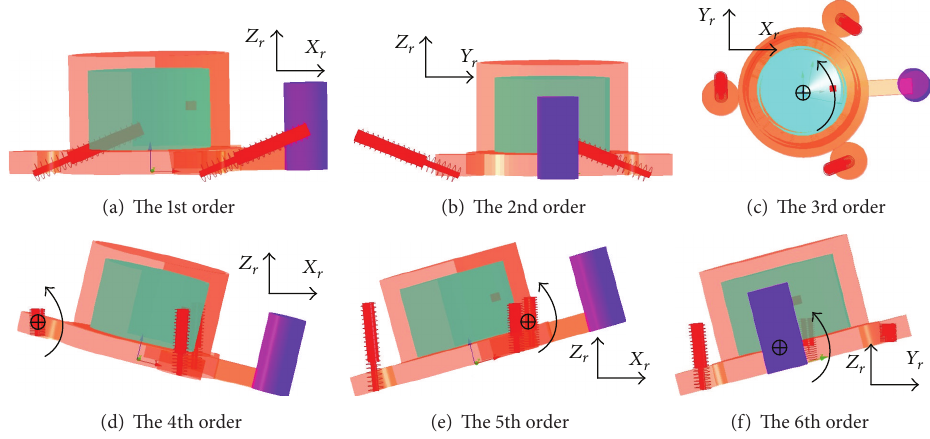
Figure 2: Mode shapes of the system. “ ⊕ ” denotes the rotational center.